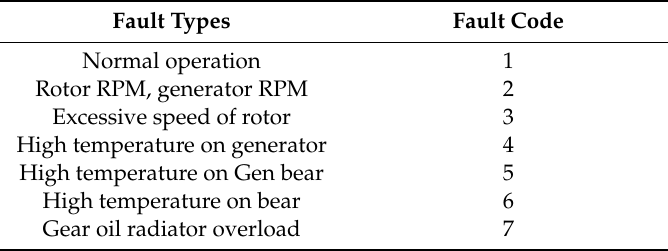
Table 2. Fault code.